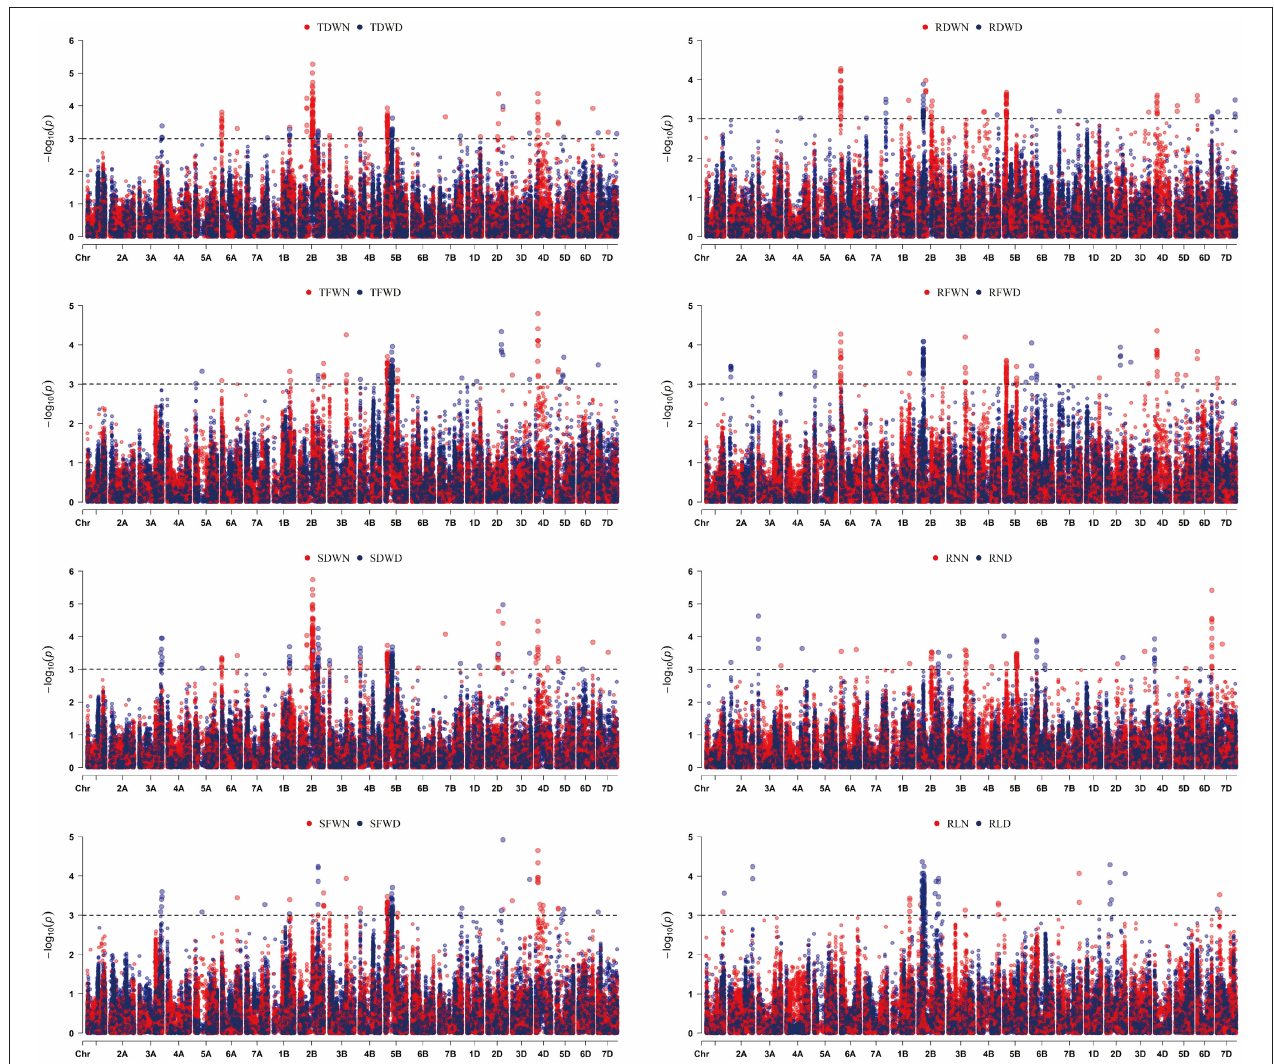
FIGURE 2 | Manhattan plots for the eight root and seedling biomass traits identified by genome-wide association study (GWAS) using BLUP values. The dashed line represents the significance threshold (–log10 P = 3.0). Trait abbreviations: RLD, root length in drought environment; RLN, root length in controlled environment; RND, root number in drought environment; RNN, root number in controlled environment; RDWN, root dry weight in controlled environment; RDWD, root dry weight in dry environment; RFWN, root fresh weight in controlled environment; RFWD, root fresh weight in dry environment; SFWN, shoot fresh weight in controlled environment; SFWD, shoot fresh weight in dry environment; SDWN, shoot dry weight in controlled environment; SDWD, shoot dry weight in drought environment; TFWN, total fresh weight in controlled environment; TFWD, total fresh weight in drought environment; TDWN, total dry weight in controlled environment; TDWD, total dry weight in drought environment.